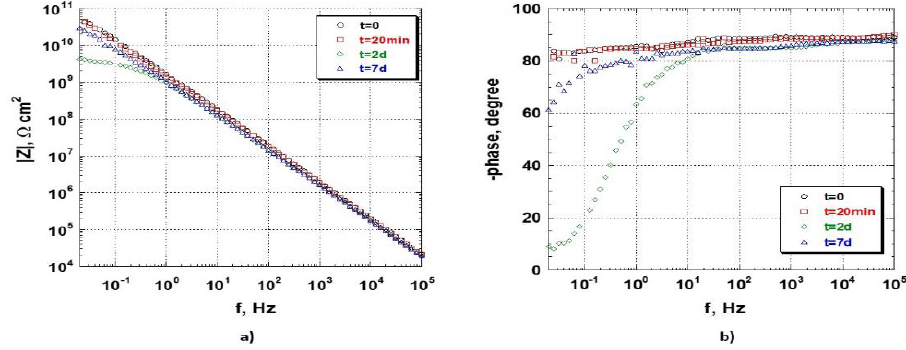
Figure 6. ( a ) Impedance modulus |Z|; ( b ) phase angle plots of bare sample immersed in an aerated 3.5 wt.% NaCl solution for 7 days.